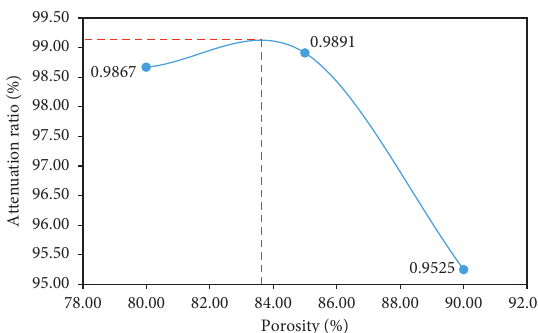
Figure 15: Wave elimination rate curve of aluminum foam under different